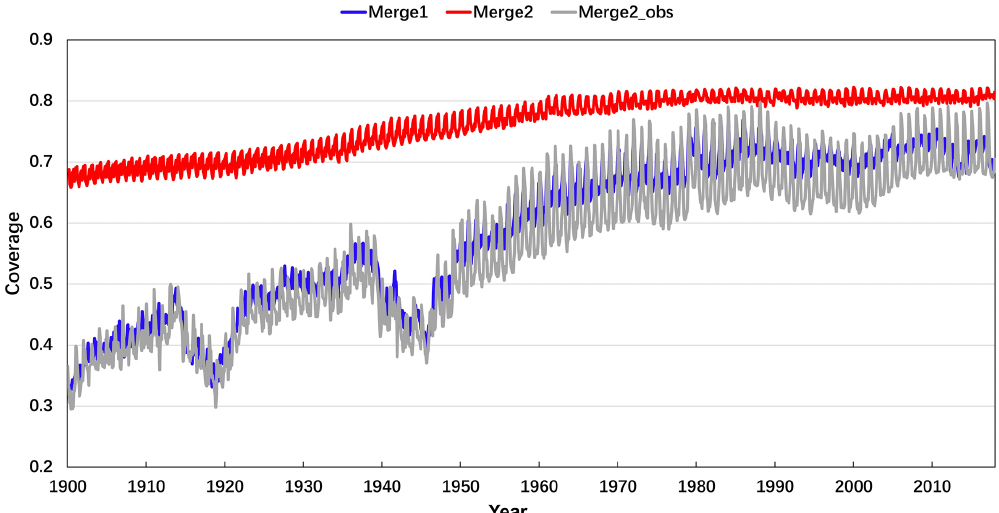
Figure 3. Comparison of monthly global coverage of the two datasets from 1900 to 2017. The grey line is Merge2 but using the original data.